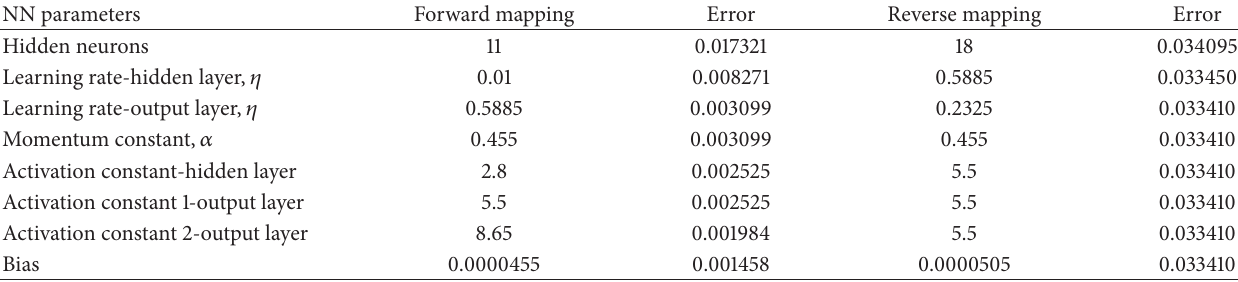
Table 2: BPNN parametric study results of both forward and reverse mappings.